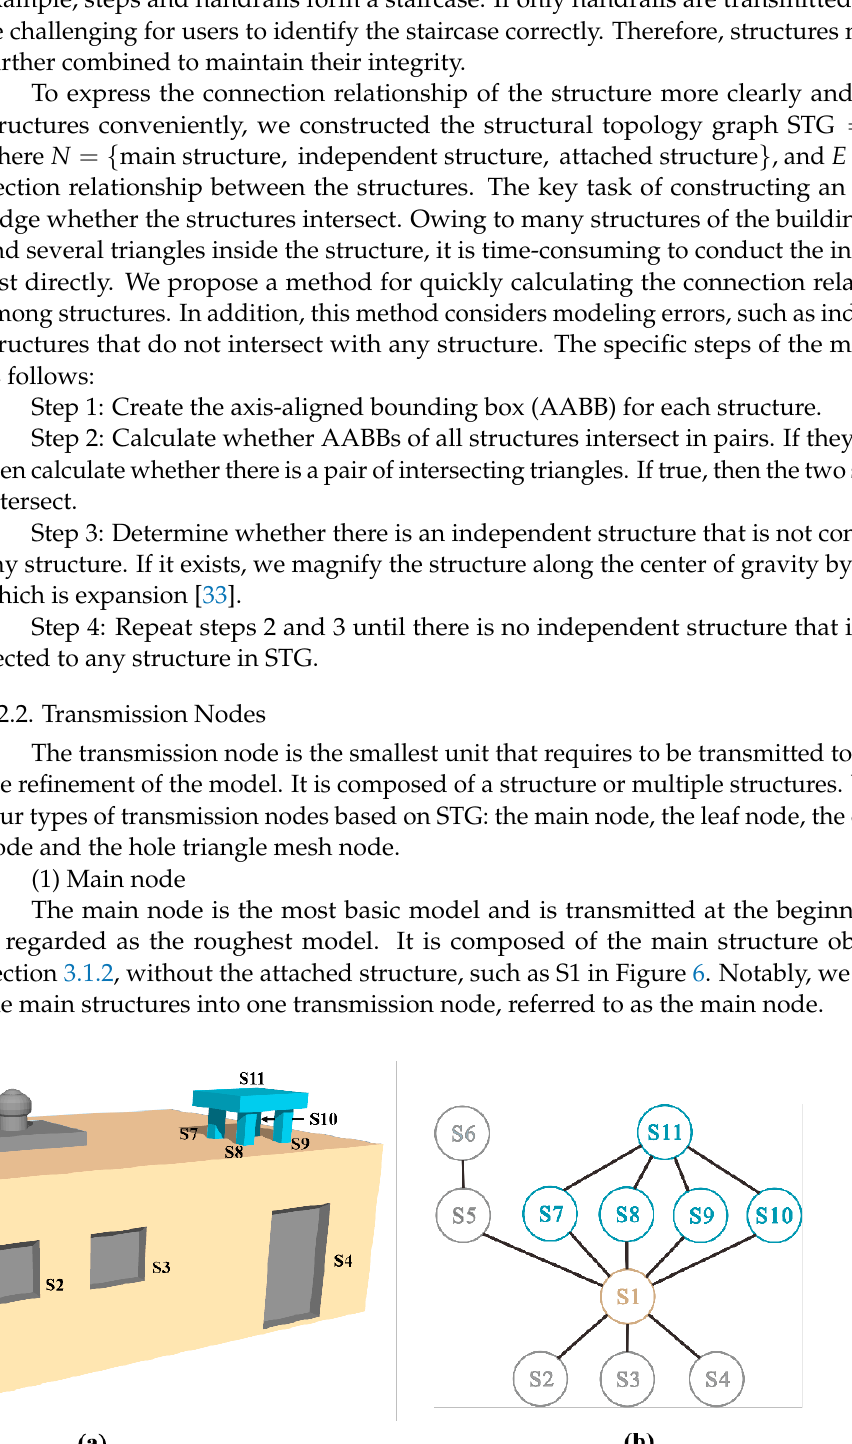
Figure 7. All generation paths from structure to transmission node. Figure 8 delineates the extraction results for various transmission nodes. Since the hole triangle nodes are covered by the other nodes, they are not shown in Figure 8.